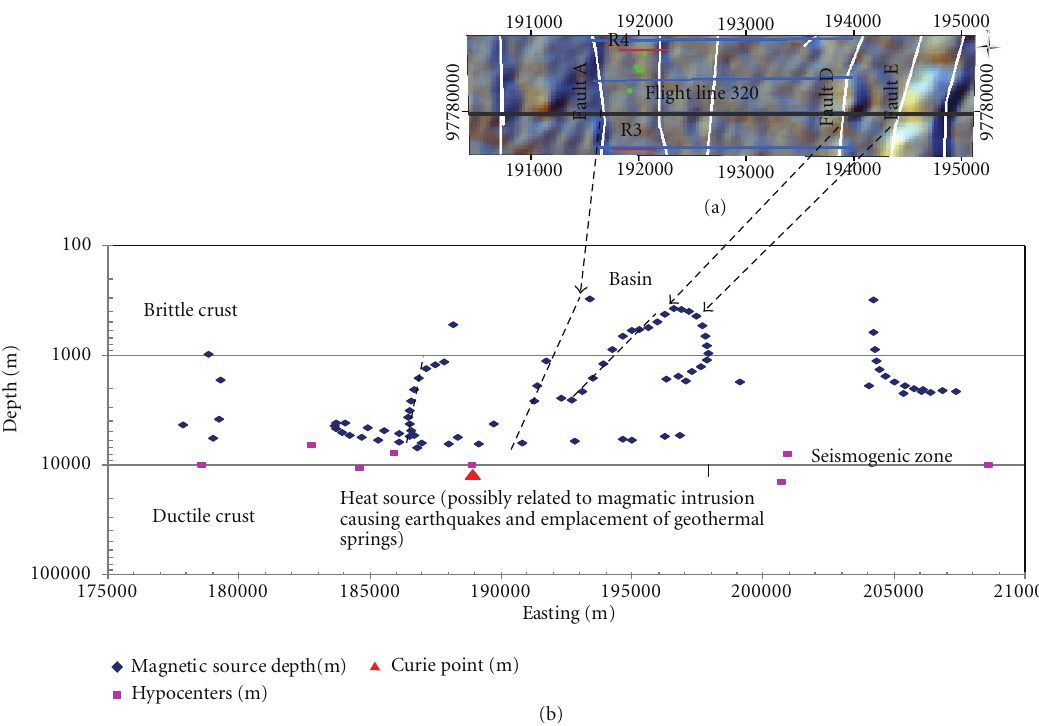
Figure 17: (a) Hill-shaded ASTER DEM subset showing the surface lineaments and the extracted aeromagnetic flight line 320. (b) Scatter plots showing the subsurface relationship between magnetic sources on flight line 320, the hypocenters, and the Curie-point (heat source). The magnetic sources are generated from 2D Euler deconvolution using structural index of 1 (i.e., contacts, faults) and inclinations and angles of − 26.3 ◦ and 0.002 ◦ , respectively. R3 and R4 are the resistivity profiles 3 and 4, respectively. The blue horizontal lines are the ground magnetic profiles